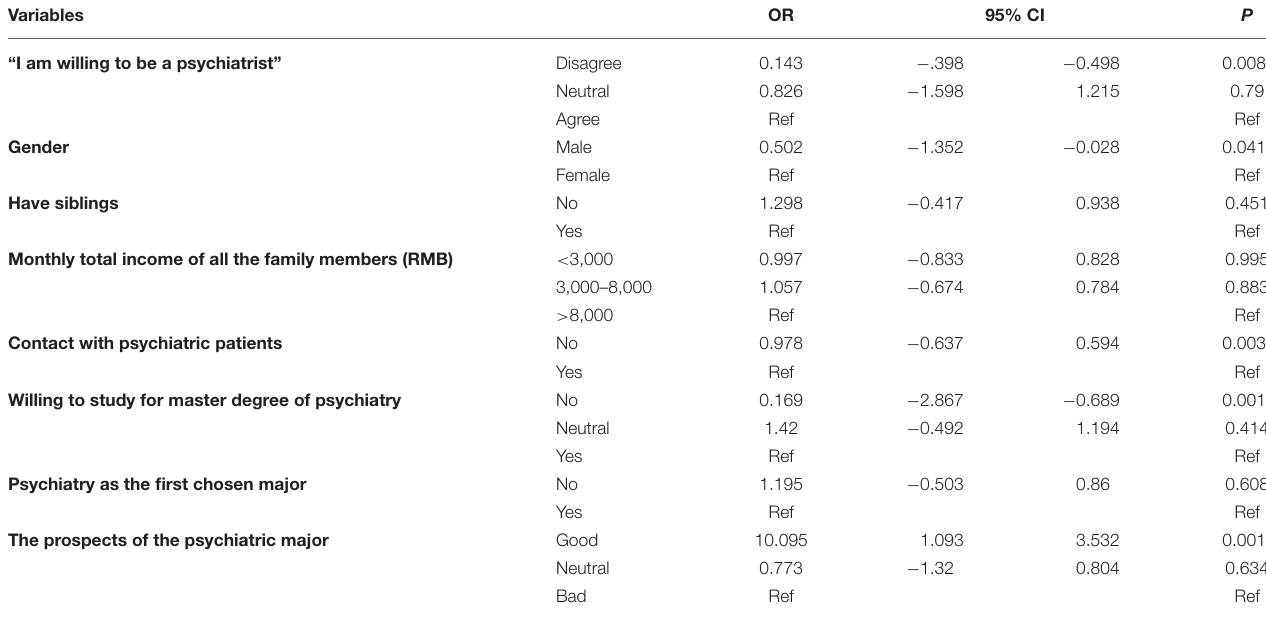
TABLE 4 | Multiple logistic regression model for “ATP item 4.”